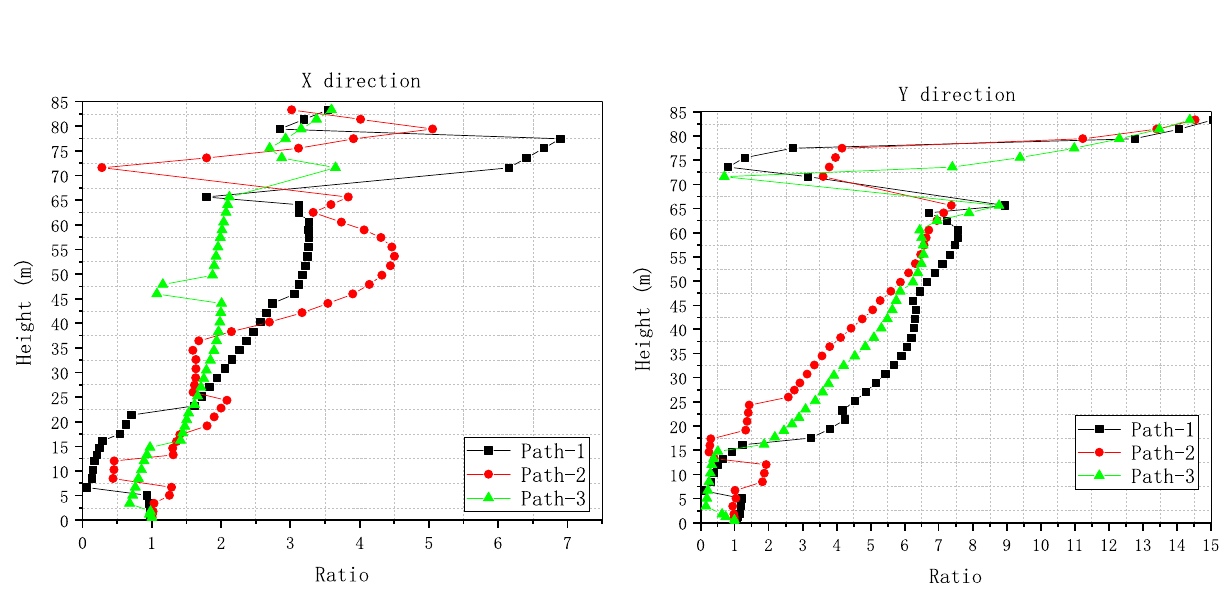
Figure 31. Amplification ratio of the peak acceleration along the Z